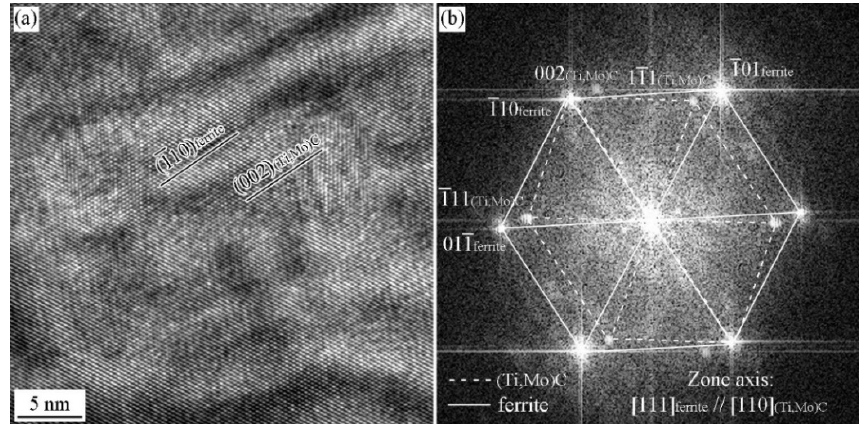
Figure 11. HRTEM image of precipitates and the ORs between the precipitates and ferrite matrix in the Ti-Mo steel produced by process II with the cooling rate of 20 °C/s ( a ) HRTEM image; ( b ) FFT diffractogram.